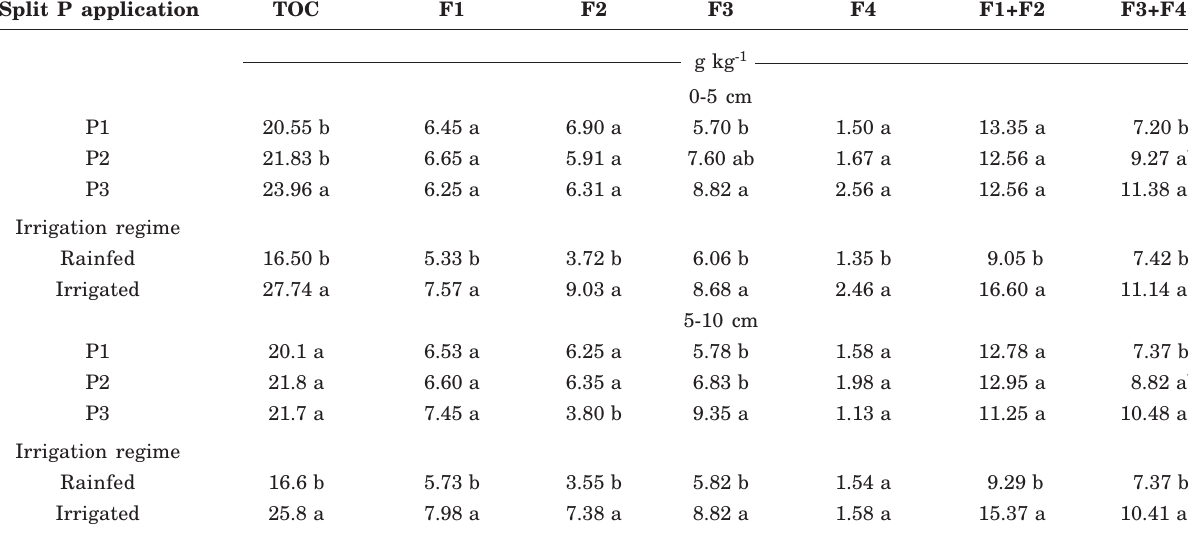
Table 4. Carbon fractions of oxidizable organic matter and total organic carbon (TOC) in soil under coffee with irrigation regimes (rainfed and irrigated) and split P applications in two layers